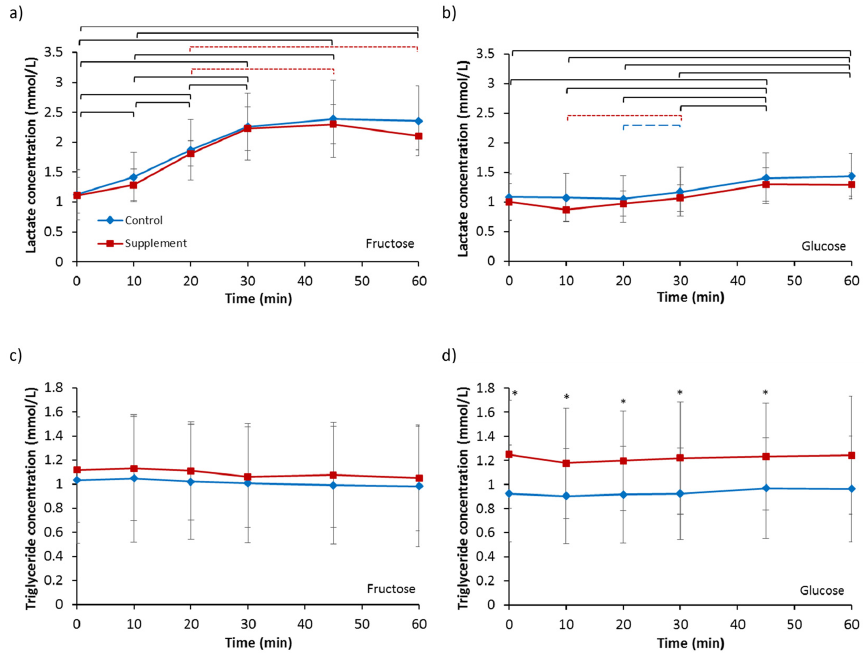
Figure 5. Serum concentrations of lactate following ingestion of ( a ) a 6% fructose solution and ( b ) a 6% glucose solution and serum concentrations of triglyceride following ingestion of ( c ) a 6% fructose solution and ( d ) a 6% glucose solution. Treatments were control without fructose supplementation and with three days of supplementation with 120 g fructose per day. Brackets denote significant difference between time ‐ points, blue long dashed for control trial only, red small dashed for supplement trial only and black solid for both trials ( p < 0.05). * Significantly greater for supplement compared to control ( p < 0.05). Values are mean ± standard deviation.